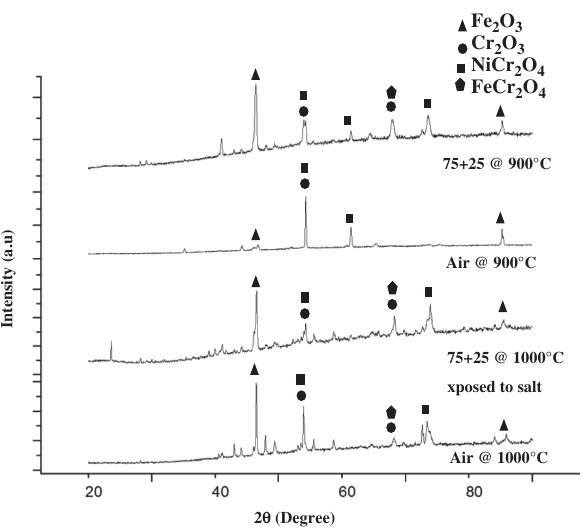
Figure 13: XRD peaks show the predominant oxides formed during oxidation and hot corrosion studies on Hastelloy